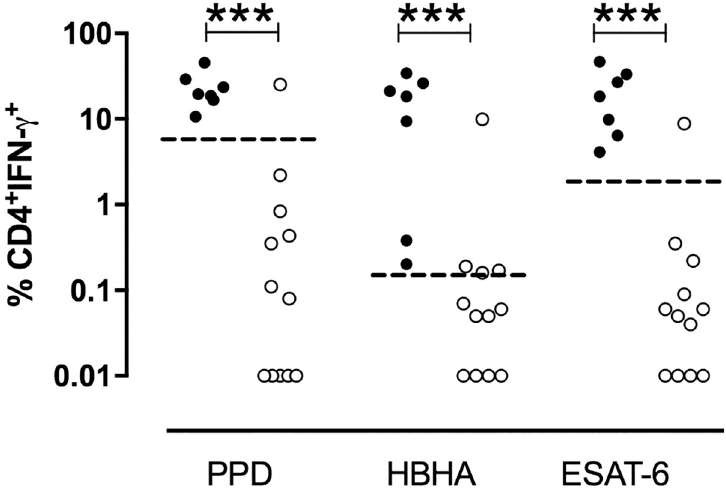
Fig 4. Percentages of IFN- γ -containing CD4 + ascites T lymphocytes induced by PPD, HBHA or ESAT-6. Ascites lymphocytes were in vitro cultured overnight in the absence or presence of PPD, HBHA ESAT-6, and the percentages of IFN- γ -containing CD4 + T lymphocytes were analyzed by flow cytometry. The values shown are obtained by subtracting the values obtained in the absence of antigen stimulation from those obtained in response to mycobacterial antigens. Filled circles represent values from patients suffering from TB, whereas open circles represent values from non-TB patients. Dotted horizontal lines represent the cut-offs determined by ROC analysis comparing the values for TB patients with those for non-TB patients. Values obtained for TB and non-TB patients were compared by Mann- Whitney U test. ��� , P < 0,001.